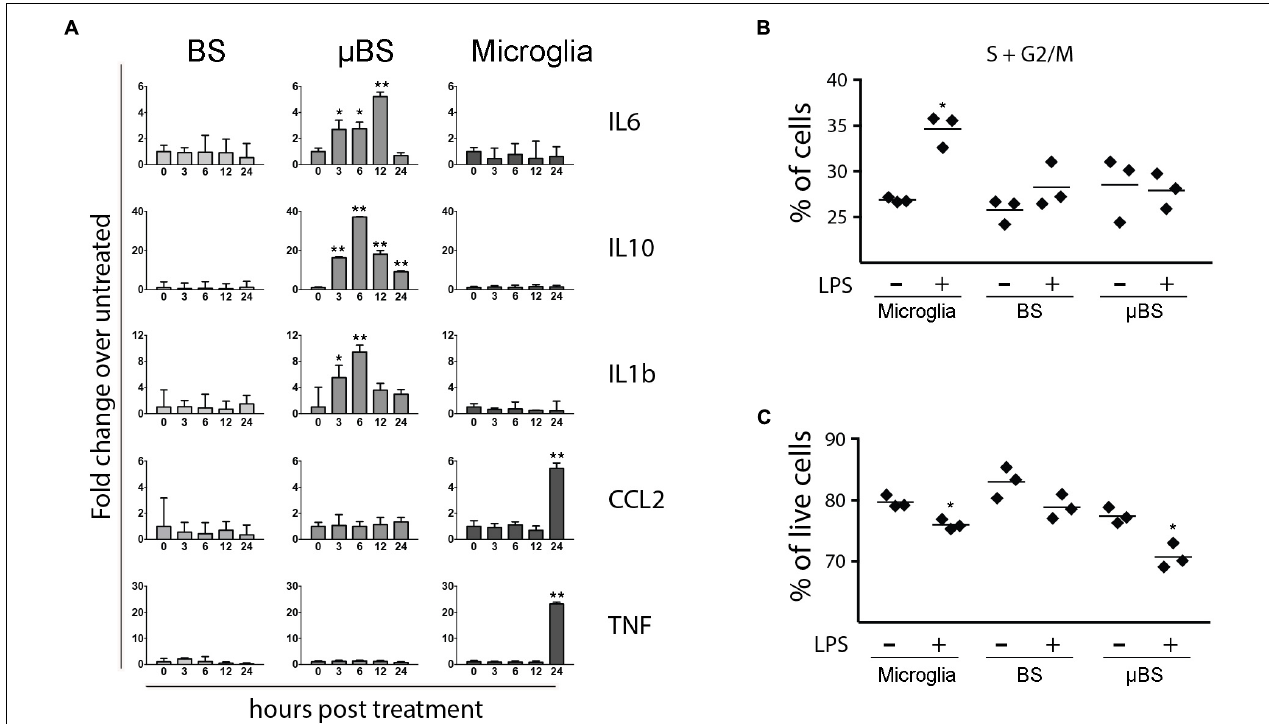
FIGURE 2 | Differences between BS, µ BS, and microglia after LPS treatment. The microglia, BS, µ BS, were exposed to 20 ng/mL LPS up to 24 h. (A) shows gene expression of IL6, IL10, IL1b, CCL2, and TNFa after LPS treatment on the different models (BS, µ BS, and microglia cells). Data are shown as fold change of treated versus untreated up to an hour post treatment (3, 6, 12, and 24 h after treatment). (B) show changes in cell cycle in percentage of the cells in G2 plus S phase in microglia cells, BS and µ BS treated or non-treated with LPS. Each dot symbol represent a replicate sample (n+3). (C) shows Annexin V Apoptosis Muse assay. Results show % live cells microglia, BS, ad µ BS cells treated (+) or not treated (–) with LPS. Each symbol represent a replicate ( n = 3). Statistical analysis in A was performed using Dunnett test on (cid:49)(cid:49) Ct. The asterisks symbols represents ∗ P < 0.05 and ∗∗ P < 0.01 (two independent experiments and three biological replicates on each